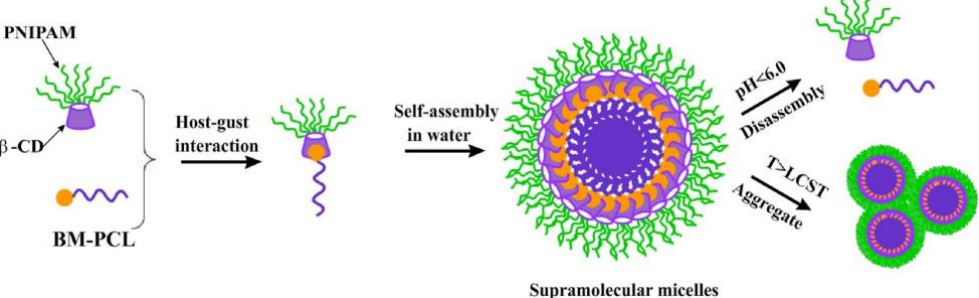
Figure 2. Diagram illustrating the creation of temperature- and pH-sensitive supramolecular micelles from the star polymer β -CD-PNIPAM (reproduced with permission of Elsevier from ref. [30]).